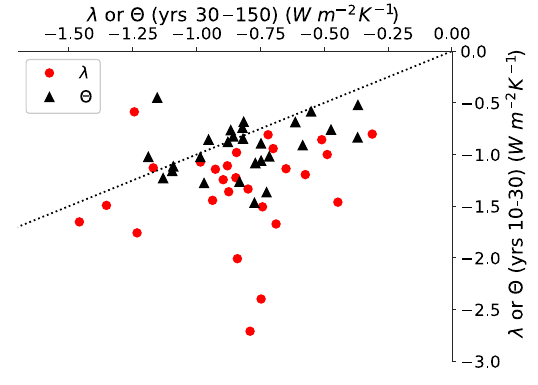
Figure 8. Scatterplot of λ 10 − 30 vs. λ 30 − 150 (red circles) in CMIP5 abrupt 4 × CO 2 runs, as well as (cid:50) 10 − 30 vs. (cid:50) 30 − 150 (black tri- angles) in the same models. Each point represents one model. The dotted line is the 1 : 1 line. The subscripts (10–30, 30–150) indicate the years of the run from which the values are calculated.